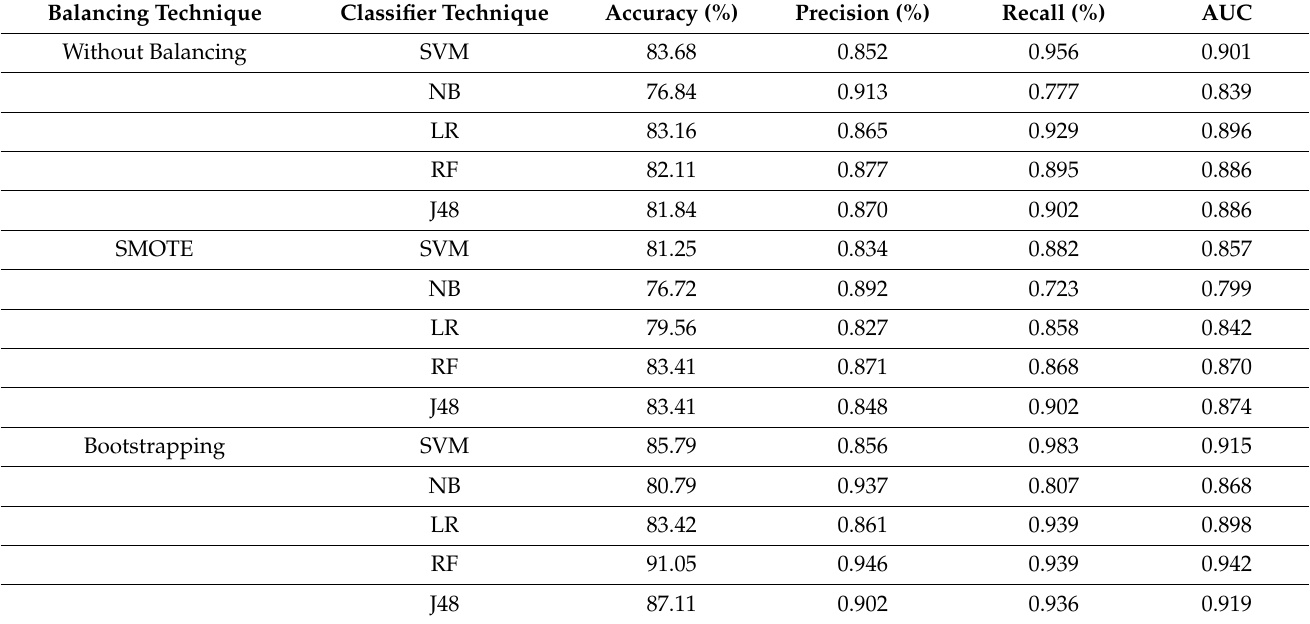
Table 6. Performance of the classifiers using the Gain Ratio technique.